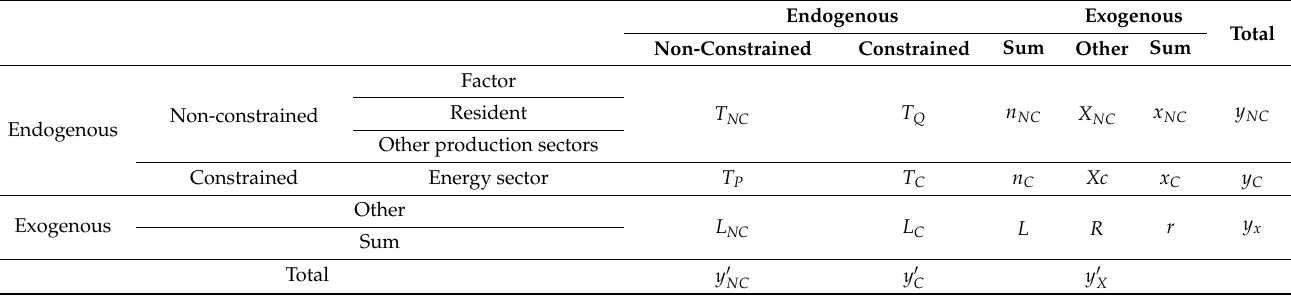
Table 3. The SAM with constrained and non-constrained